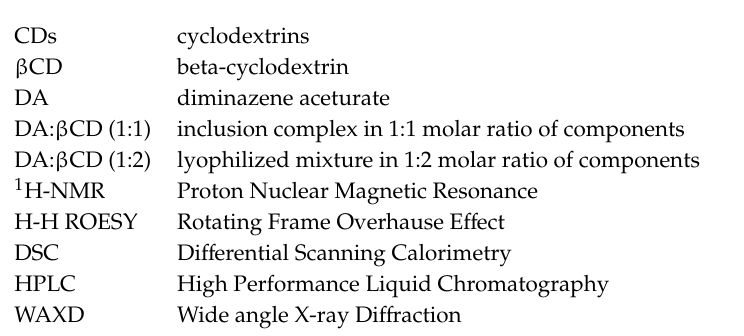
Figure S1. (A) The ROESY spectrum of DA: β CD inclusion complex of 1:2 molar ratio, recorded in D 2 O, with suppression of the water signal; (B) Expansion of the ROESY spectrum showing the NOE cross-peaks between diminazene aromatic protons and the internal β CD protons H-3, H-5 and H-6. Figure S2. WAXD di ff ractograms of DA: β CD (1:1) after 18 h (red di ff ractogram) and 36 h (green di ff ractogram). Figure S3. WAXD di ff ractograms of initial β CD (black-lower); after the freeze-drying process (brown-middle); after 18 hours in water saturated atmosphere (brown-upper). Figure S4. WAXD di ff ractograms of initial DA (blue-lower); after the freeze-drying process (brown-middle); after 18 hours in water saturated atmosphere (brown-upper). Figure S5. HPLC chromatograms of: (A) DA and (B) DA: β CD (1:1) inclusion complex water solutions of 1 mg / mL DA at pH = 1.2. Mobile phase flow: 0.5 mL / min. Figure S6. HPLC chromatograms of water solutions at neutral pH (using PBS)